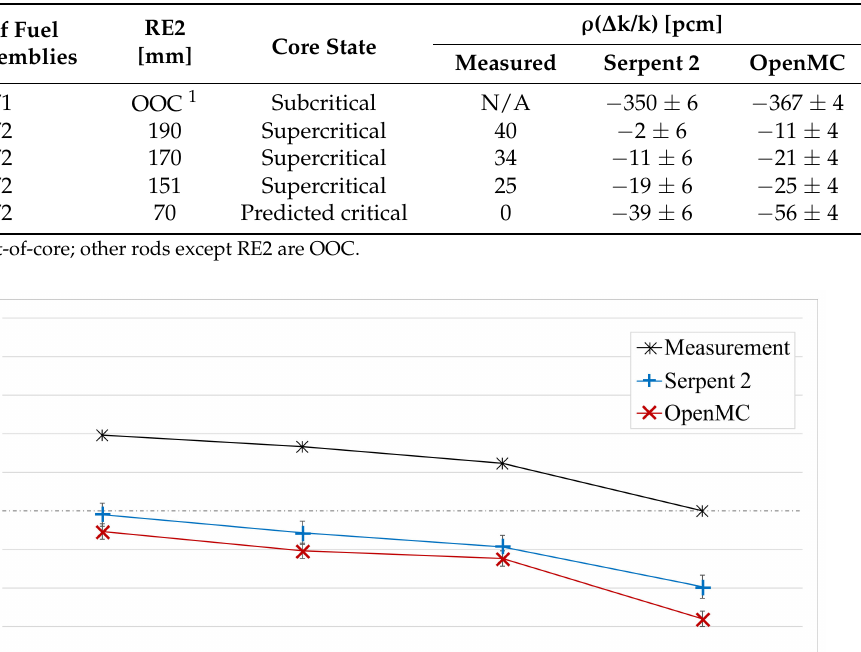
Table 3. Results of Criticality.